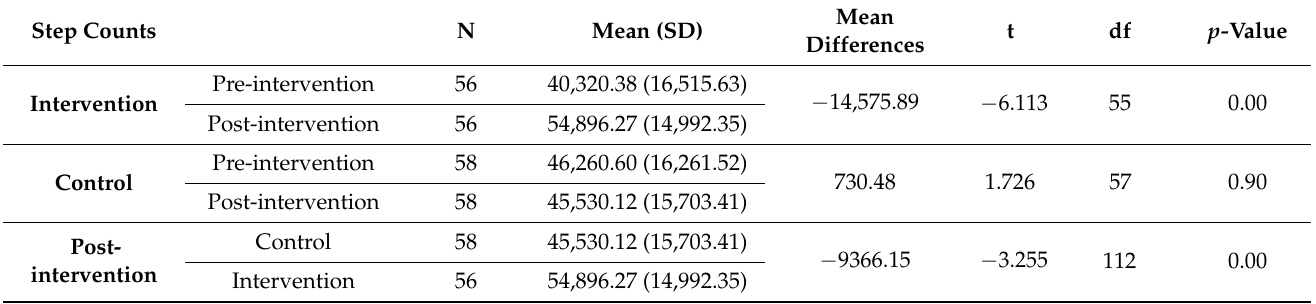
Table 2. Changes in physical activity (PA) (step counts/week) among intervention and contro groups.